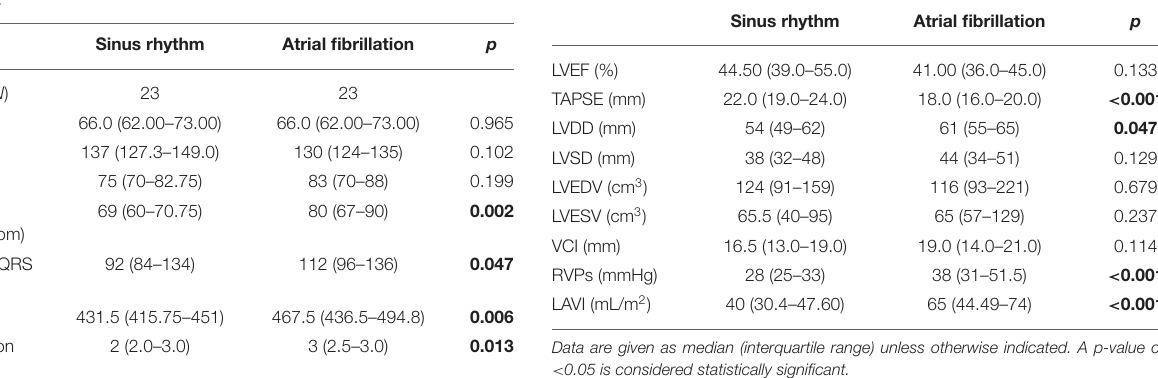
TABLE 3 | Structural echocardiographic variables in the AF and non-AF groups.